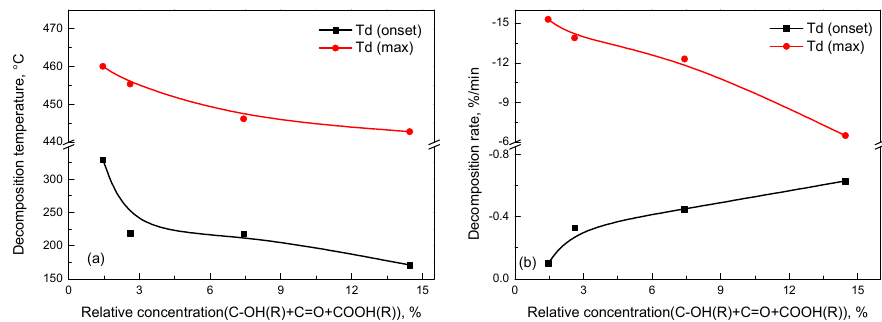
Figure 9. Relation between the relative concentration of oxygen-containing groups and ( a ) decomposition temperature or ( b ) decomposition rate based on XPS and TG-DTG.